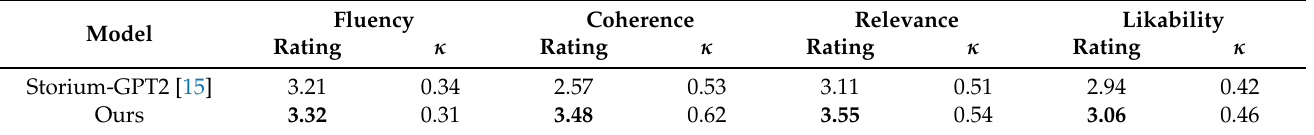
Table 4. Human evaluation results for the generated stories, with ratings scored between 1 and 5. Fleiss’ Kappa coefficient ( κ ) is used to measure annotators’ agreement, with all results indicating moderate agreement among the annotators.